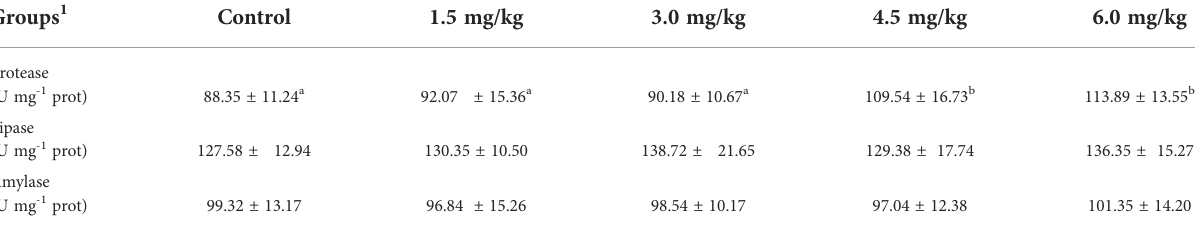
TABLE 4 Effects of PQQ on digestive enzyme activity in the intestine of yellow cat fi sh. Groups